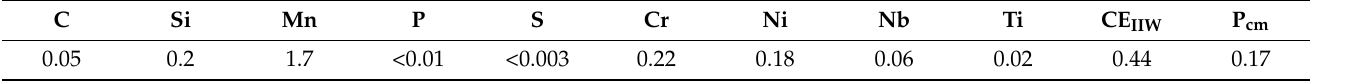
Table 1. Chemical composition and carbon equivalent of target X80 pipe steel